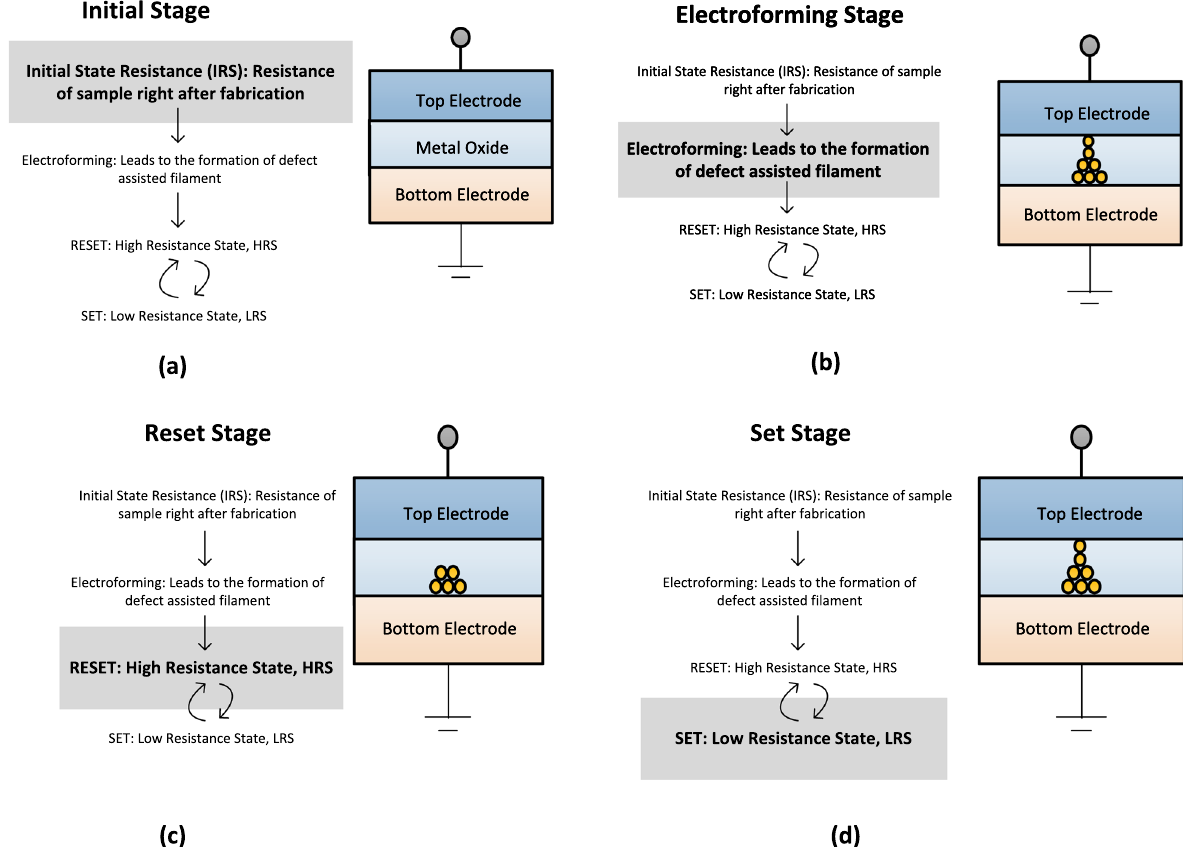
Fig. 5 Description of the switching stages of